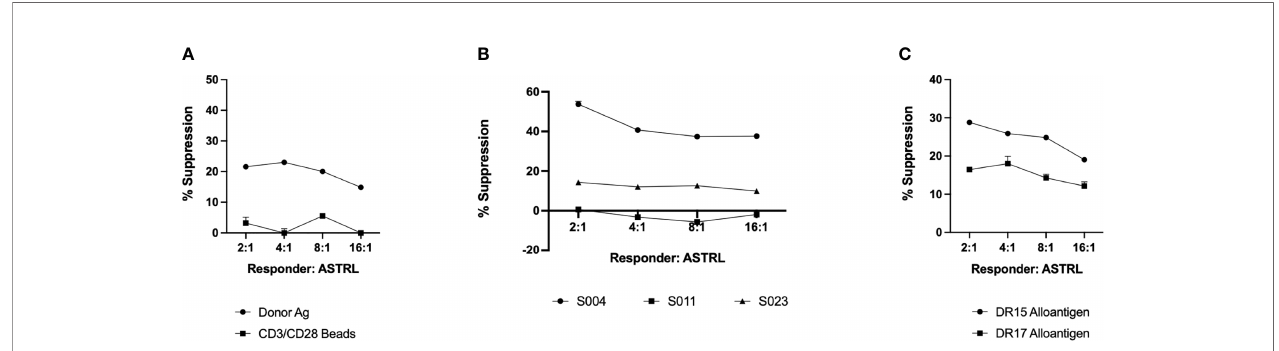
FIGURE 5 | ASTRLs exhibit antigen speci fi c, individualized/patient speci fi c and bystander suppressive function. (A) Suppressive effect of ASTRL on non-speci fi c proliferation of responder cells using CD3/CD28 beads. (B) Suppressive effect of ASTRL on antigen speci fi c proliferation of autologous and heterologous responders that share the same donor antigen. (C) Bystander suppressive effect of ASTRL on antigen speci fi c proliferation of autologous responders to multiple